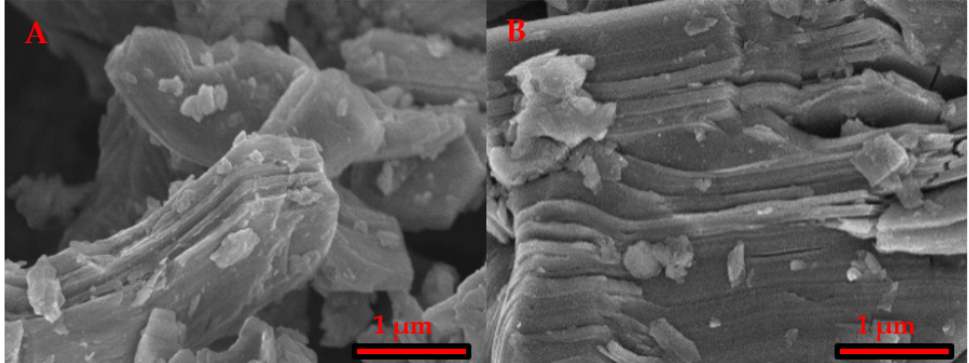
Figure 1. SEM images of ( A ) MAX phase (Ti 3 AlC 2 ) and ( B ) MXenes (Ti 3 C 2 T x ). Table 1. EDX analysis results for aluminum (Al) and titanium (Ti) atomic ratio in MAX phase and MXene samples.